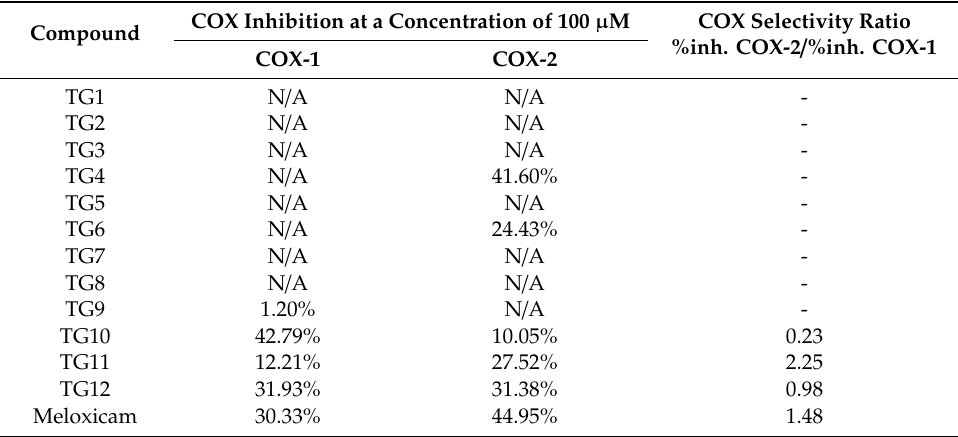
Table 1. Cyclooxygenase (COX) inhibition calculated for COX-1 and COX-2 enzymes after incubation for 2 min with the tested compounds at a concentration of 100 µM and the COX selectivity ratio. COX Inhibition at a Concentration of 100 μ M Compound